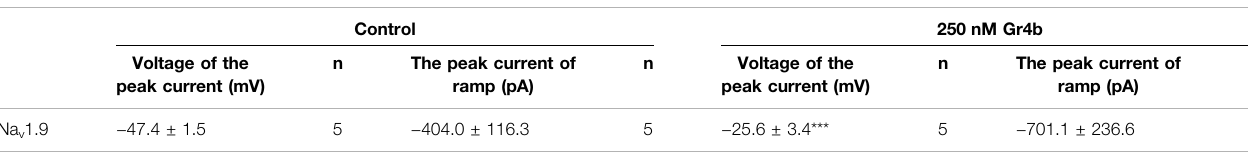
TABLE 2 | The effects of Gr4b on ramp current of Na v 1.9.